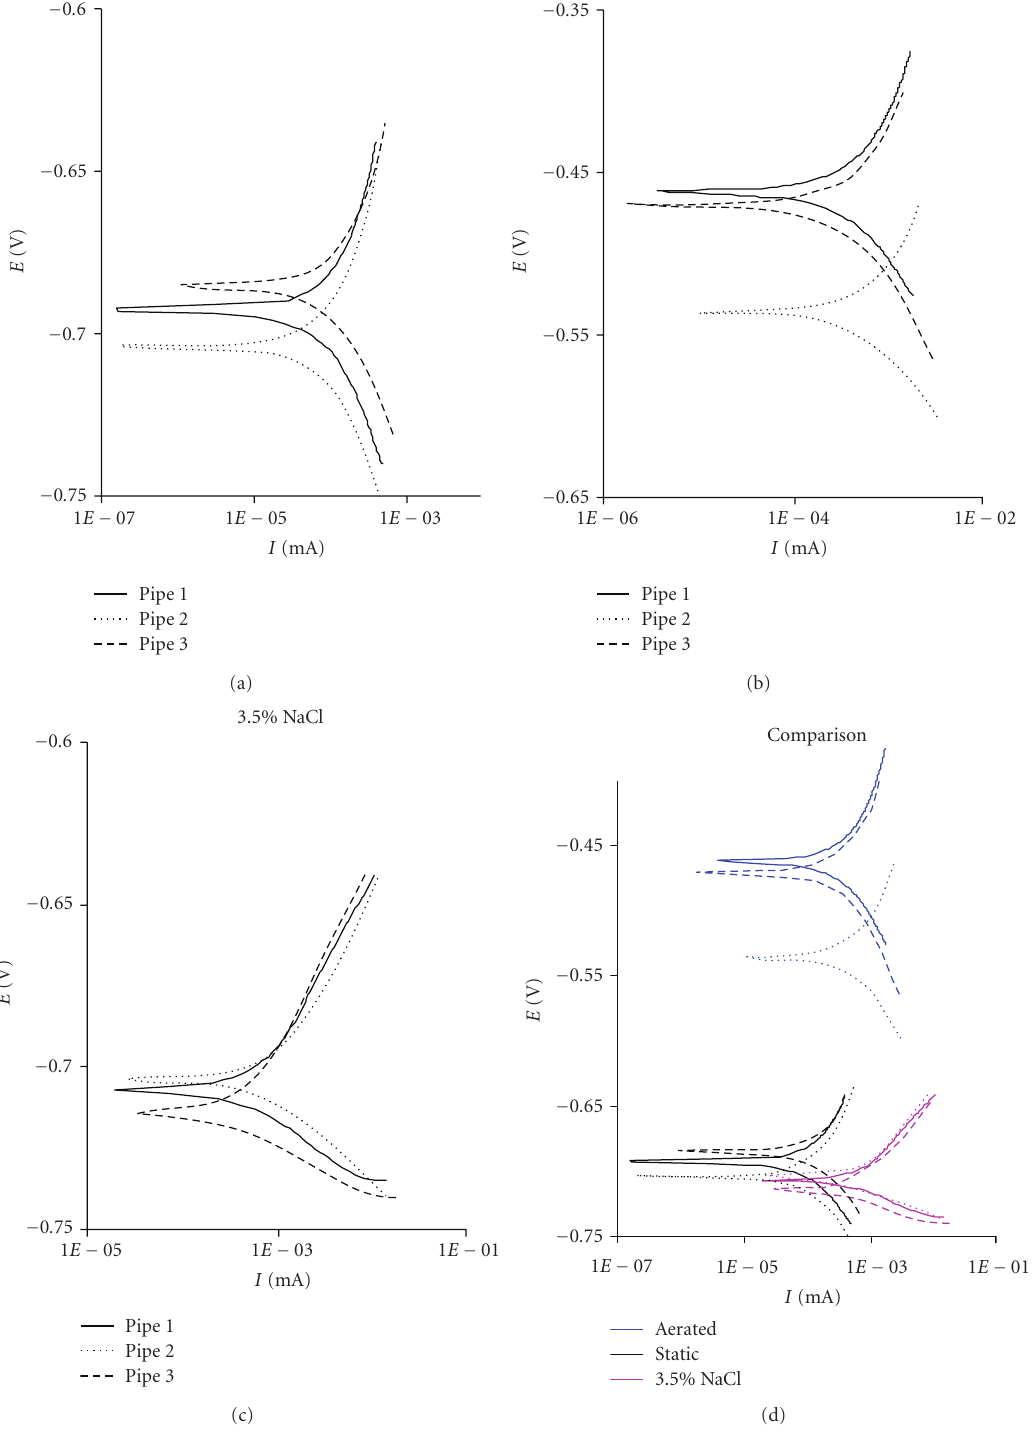
Figure 12: Example of potential polarisation